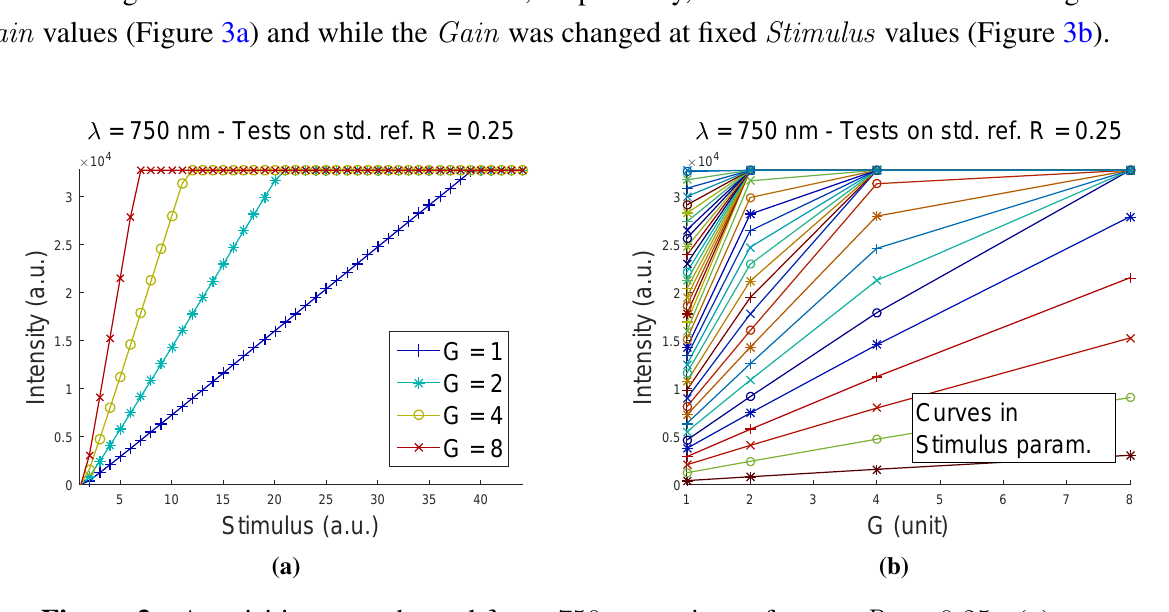
Figure 3. Acquisitions on channel λ = 750 nm, using reference R = 0 . 25 : ( a ) output Intensity vs. Stimulus for the four curves in the Gain ( G ) parameter; ( b ) output Intensity vs. Gain ( G ) in the Stimulus